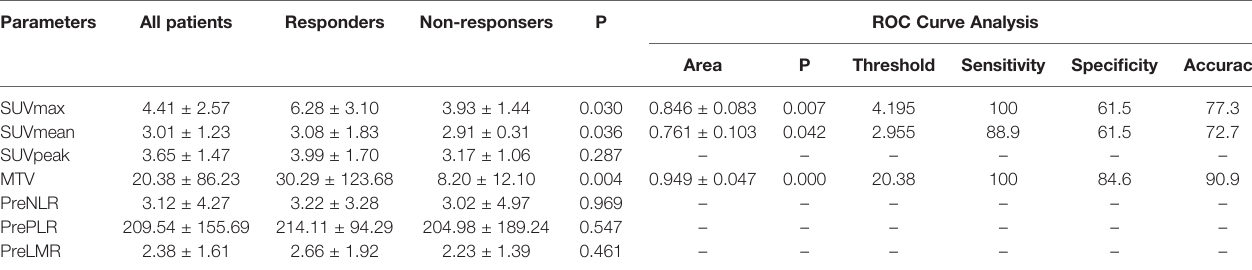
TABLE 3 | Pretreatment 18 F-RGD PET/CT and in fl ammatory biomarkers for patients, and AUC curve analysis for predicting tumor responses. Parameters All